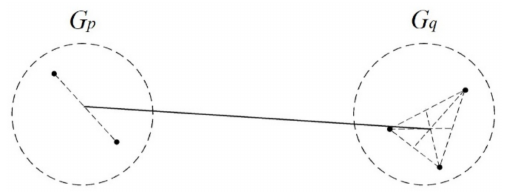
Figure 4. Conceptual diagram of the centroid